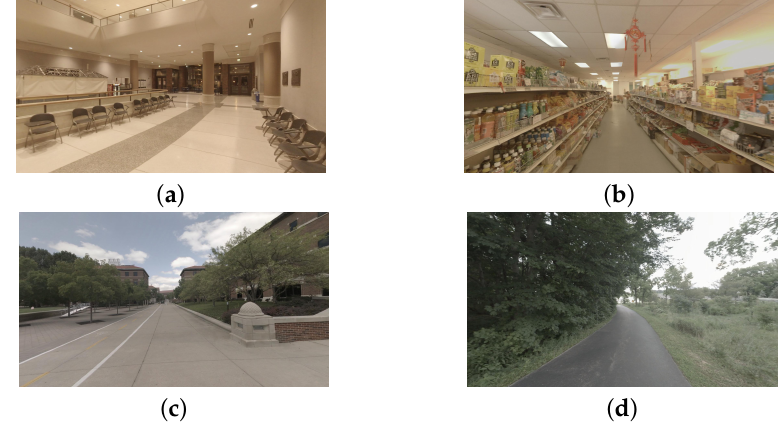
Figure 13. Example frames of source videos: ( a ) lobby; ( b ) market; ( c ) university street (US); ( d ) park walkway